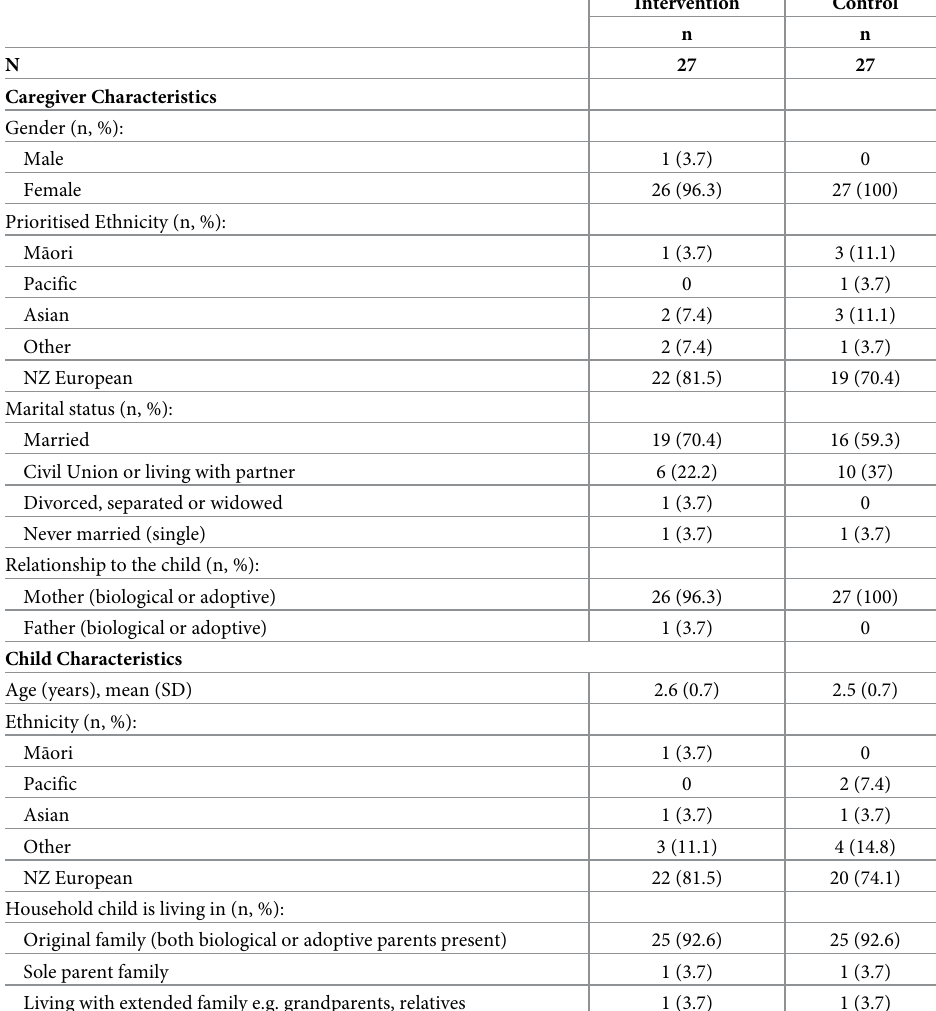
Table 1. Descriptive characteristics of the study population at